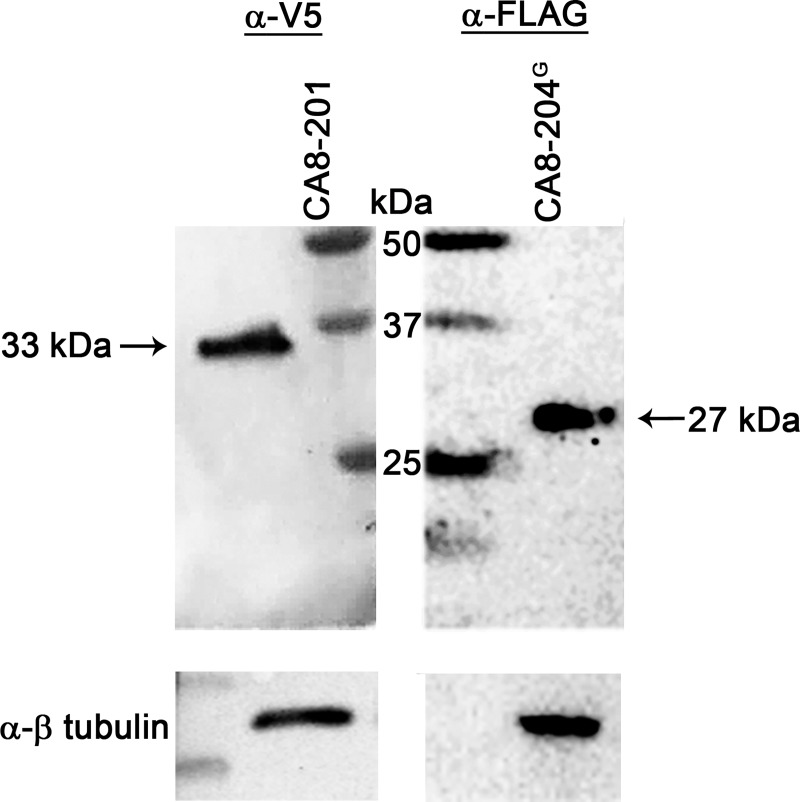
Overexpression of CA8-204 produces truncated protein product.Proteins were overexpressed through transfection with V5-CA8-201 and FLAG-CA8-204G in HEK293 cells and Immunoblotted against anti-V5, anti-FLAG (Sigma Aldrich) and anti-β tubulin (control) (Cell Signalling) antibodies, bands normalized with β-tubulin. The immunoblots on left panel represent V5-CA8-201, The right panel represent FLAG-CA8-204G, size comparisons are facilitated by markers (middle). The truncated product from CA8-204G (~27 kDa) distinguished in size from the WT CA8-201. We were unable to find expression of CA8-204G in NBL cells.